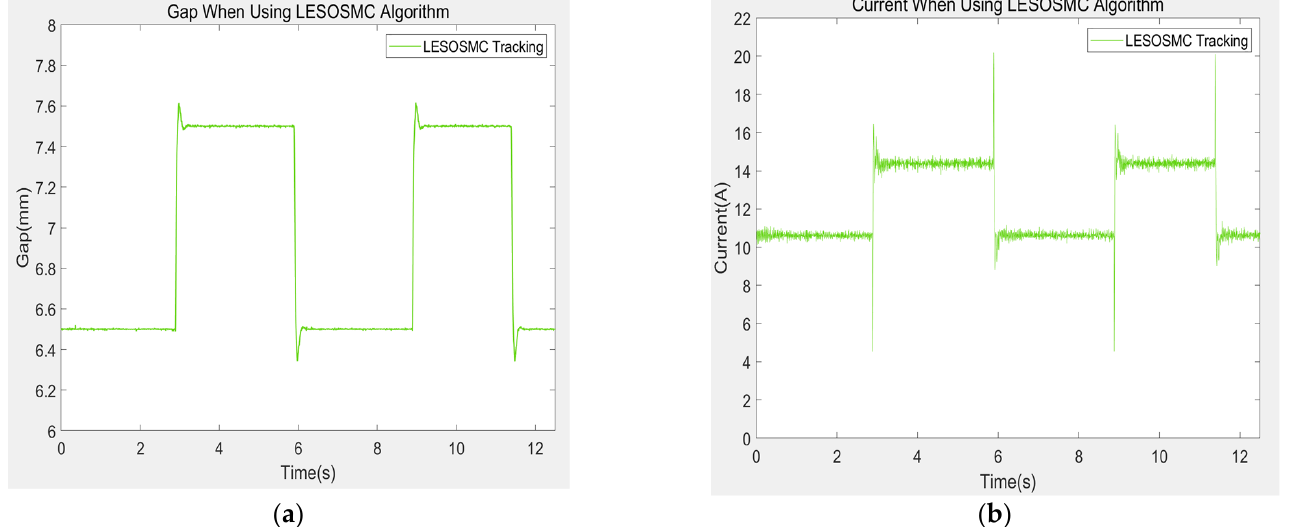
Figure 22. Gap and current value under LESOSMC control algorithm: ( a ) Gap value; ( b ) current value.